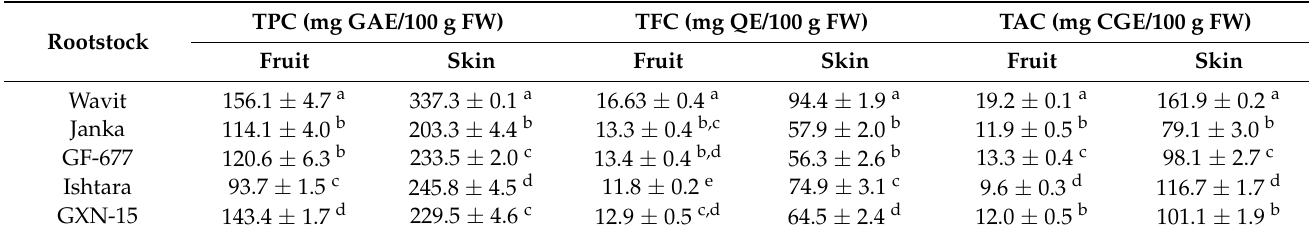
Table 2. Total phenolic (TPC), total flavonoid (TFC), and total anthocyanin (TAC) content in the fruit and fruit skins of plums growing on different